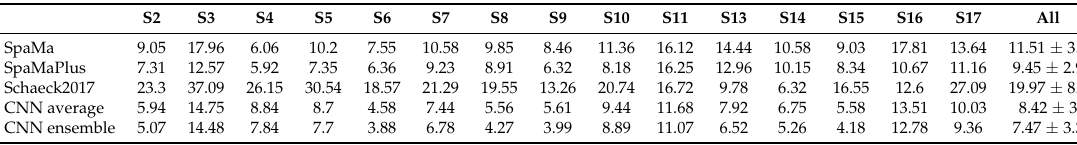
Table 9. Session-wise evaluation results on the dataset WESAD , achieved with the three classical methods and the best performing CNN architecture (ensemble prediction; results averaging the 7 repetitions are given for comparison). Results are given as MAE